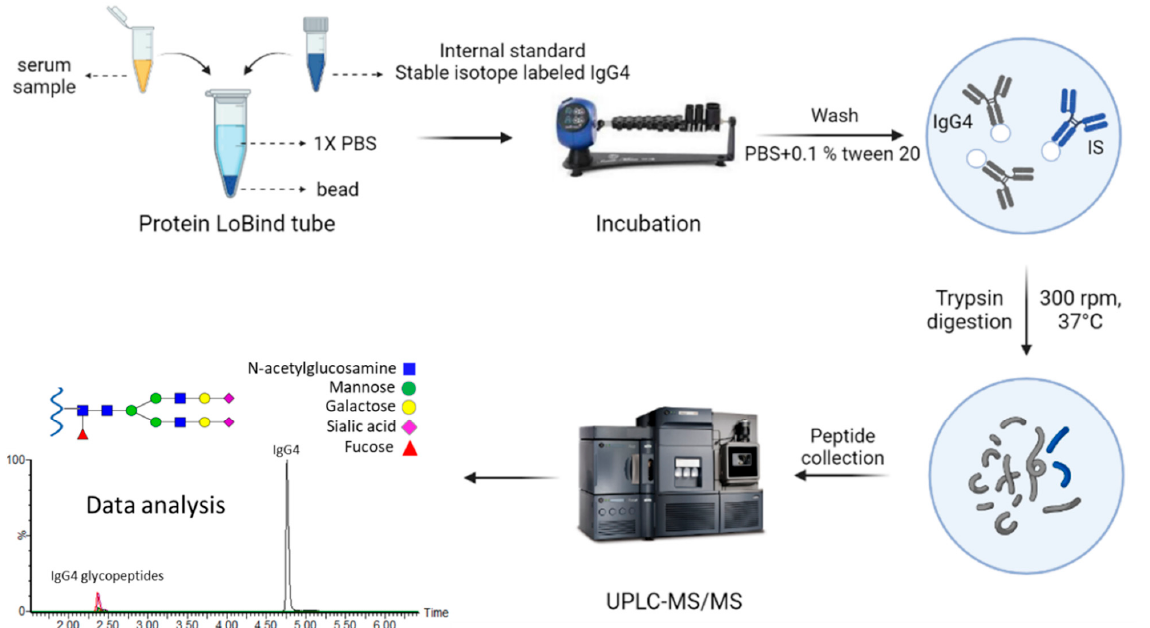
Figure 4. Workflow of affinity purification coupled to UHPLC-MS/MS analysis for IgG4 and glycopeptides investigation.